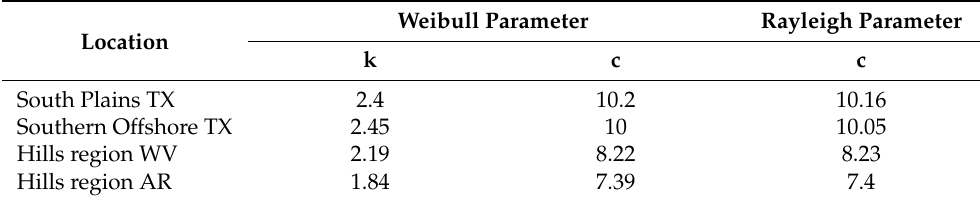
Table 1. Scale and shape parameters for four locations for the year